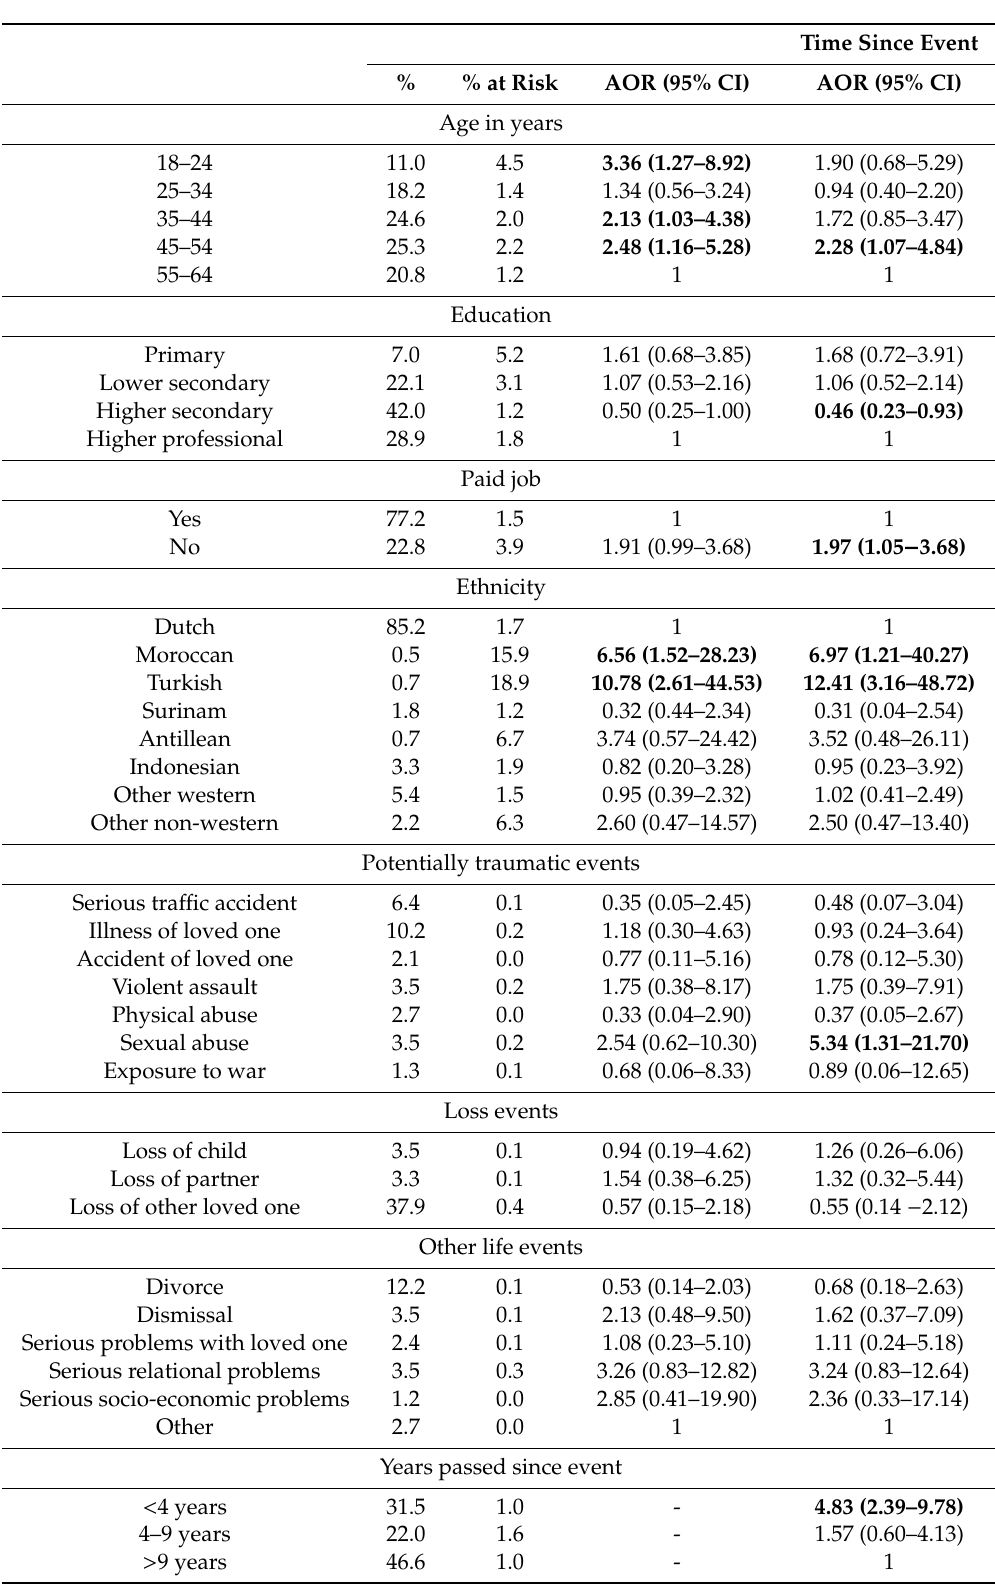
Note. Weighted percentages, odds ratios and 95% confidence intervals for being at risk for PTSD given exposure (6 or more TSQ items endorsed); Numbers in bold indicate significant odds